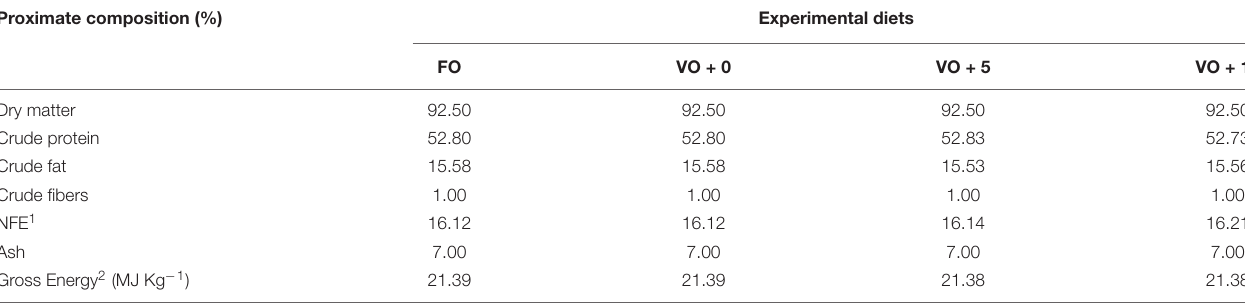
TABLE 1 | Proximate composition of the four different experimental diets. Proximate composition (%)